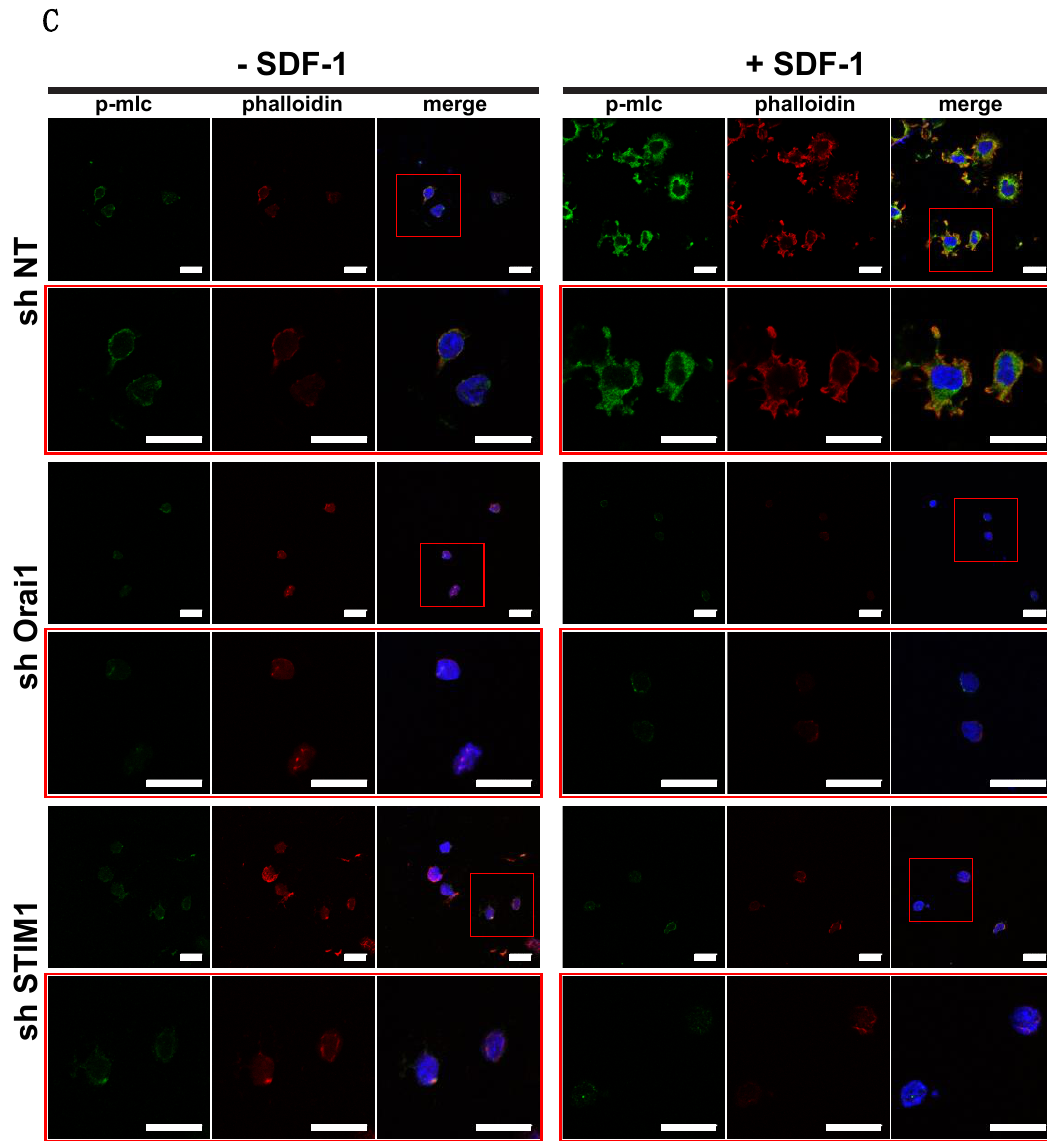
Figure 4. Orai1 and STIM1 control DLBCL cell migration through RhoA activation, ROCK, and MLC phosphorylation. ( A ) SDF-1-induced SU-DHL-4 and HLY-1 cell migration is ROCK activation dependent. Cells incubated or not with SDF-1 (100 ng/mL) were pre-treated during 20 min in the presence or not of various inhibitors (FAK inhibitor 1 µM, PD98059 a MEK inhibitor 10 µM, Wortmannin a PI3K inhibitor 10 nM, AKT inhibitor 250 nM, Y27632 a ROCK inhibitor 1 µM). Data are represented as mean ± SEM of 3 independent experiments, * p < 0.05. ( B ) SDF-1-induced RhoA activation is impaired by shOrai1 and shSTIM1 in SU-DHL-4 cells. Left : Cells were treated for 30 min with SDF-1 (200 ng/mL) and RhoA activation was evaluated by pull-down assay and western blot. Right : Quantification of western blot performed after pull-down assays (n = 3) ( C ) Orai1 and STIM1 act as regulators of the MLC phosphorylation. Immunofluorescence of SU-DHL-4 cells under-expressing, or not, Orai1 or STIM1 seeded on glass coverslips, fibronectin coated, were stimulated, or not, with SDF-1 (200 ng/mL) for 1 h. Ser 19 phosphoMLC2 was immunostained with mouse anti-phosphoMLC2 mAb revealed using secondary Alexa488-coupled donkey anti-mouse Ab (in green), F-actin was revealed with Phalloïdin-AlexaFluor 594 (in red) and nuclei were stained using Hoechst 33258 (in blue). Cells in square are zoomed and shown below. Images were acquired using a Zeiss LSM 510 meta confocal microscope (Zeiss, Göttingen, Germany) with an ApoPLAN 63× objective. Scale bar = 20 µm.